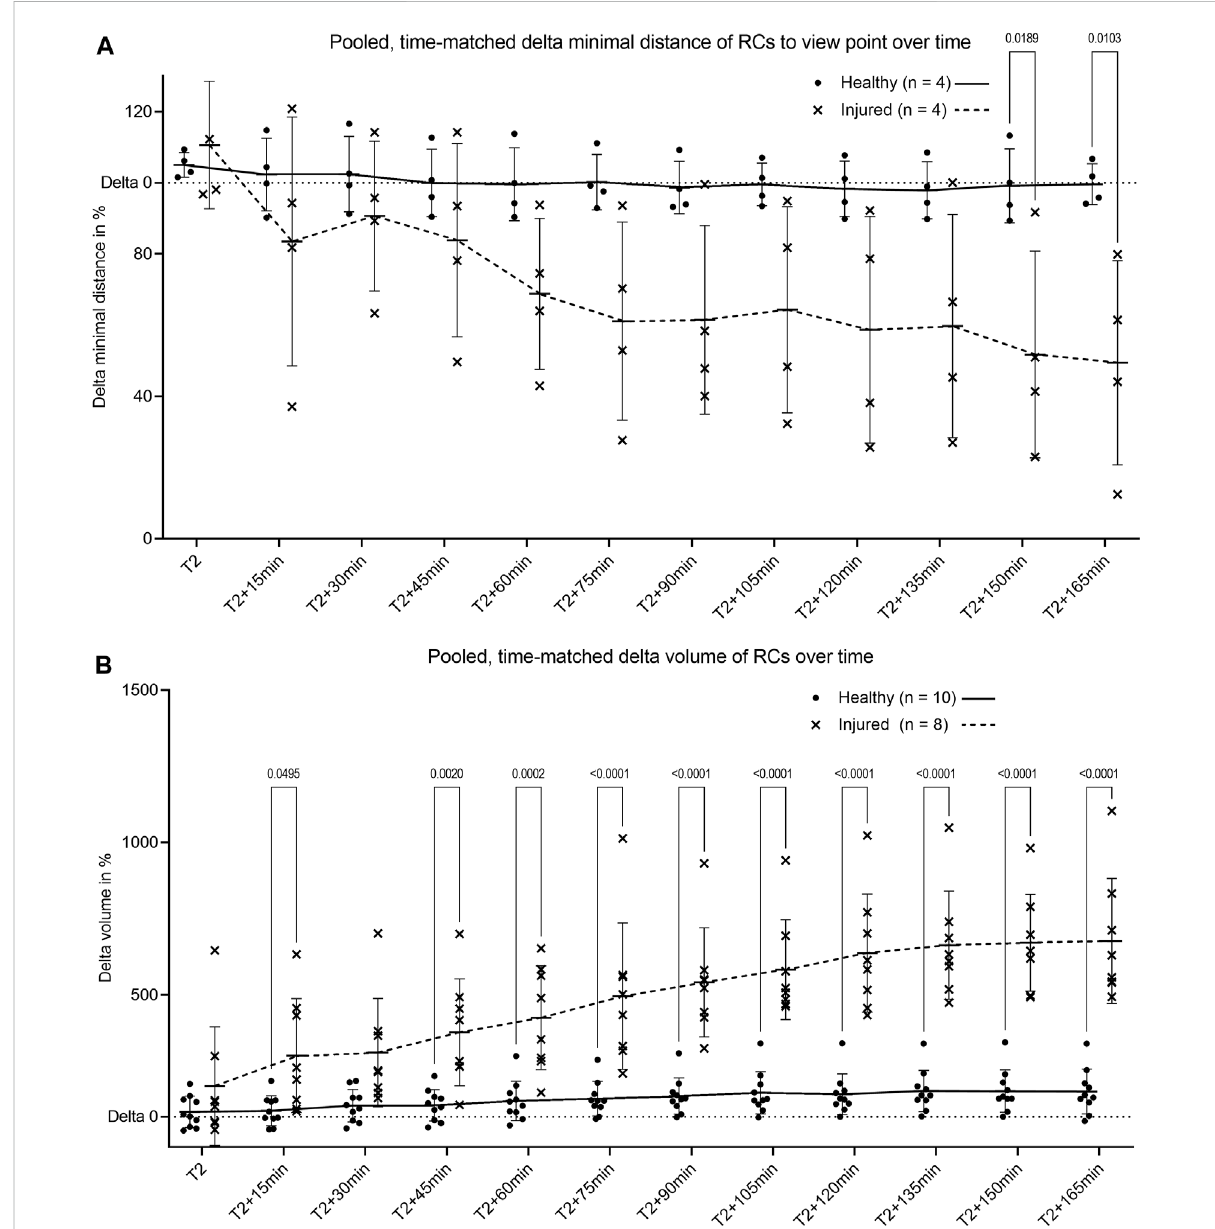
FIGURE 5 Pooled quanti fi cation of renin cell motion and migration. (A) Change of minimal distance between RC and their glomerular center for healthy glomeruli and between RC and the center of laser injury for injured glomeruli. The minimal distances were obtained by the novel automated three- dimensional image quanti fi cation based on ray tracing ( n = 4 glomeruli per group each of four different animals). (B) Intravital change of renin cell volume over time in healthy glomeruli and in laser injured glomeruli. T2 de fi nes begin of migration for injured glomeruli with matched time points fromhealthy controls. Renin cell volumes werecalculated with objectstatisticsinImaris9.7.2 basedon therenderings ofthetdTomatosignal (n = 10 glomeruli per group each of 10 different animals). Healthy and injured data were compared with two-way ANOVA tests and Tukey ’ s multiple comparisons test calculated individual mean ± SD values. The corresponding mean values are connected by trend